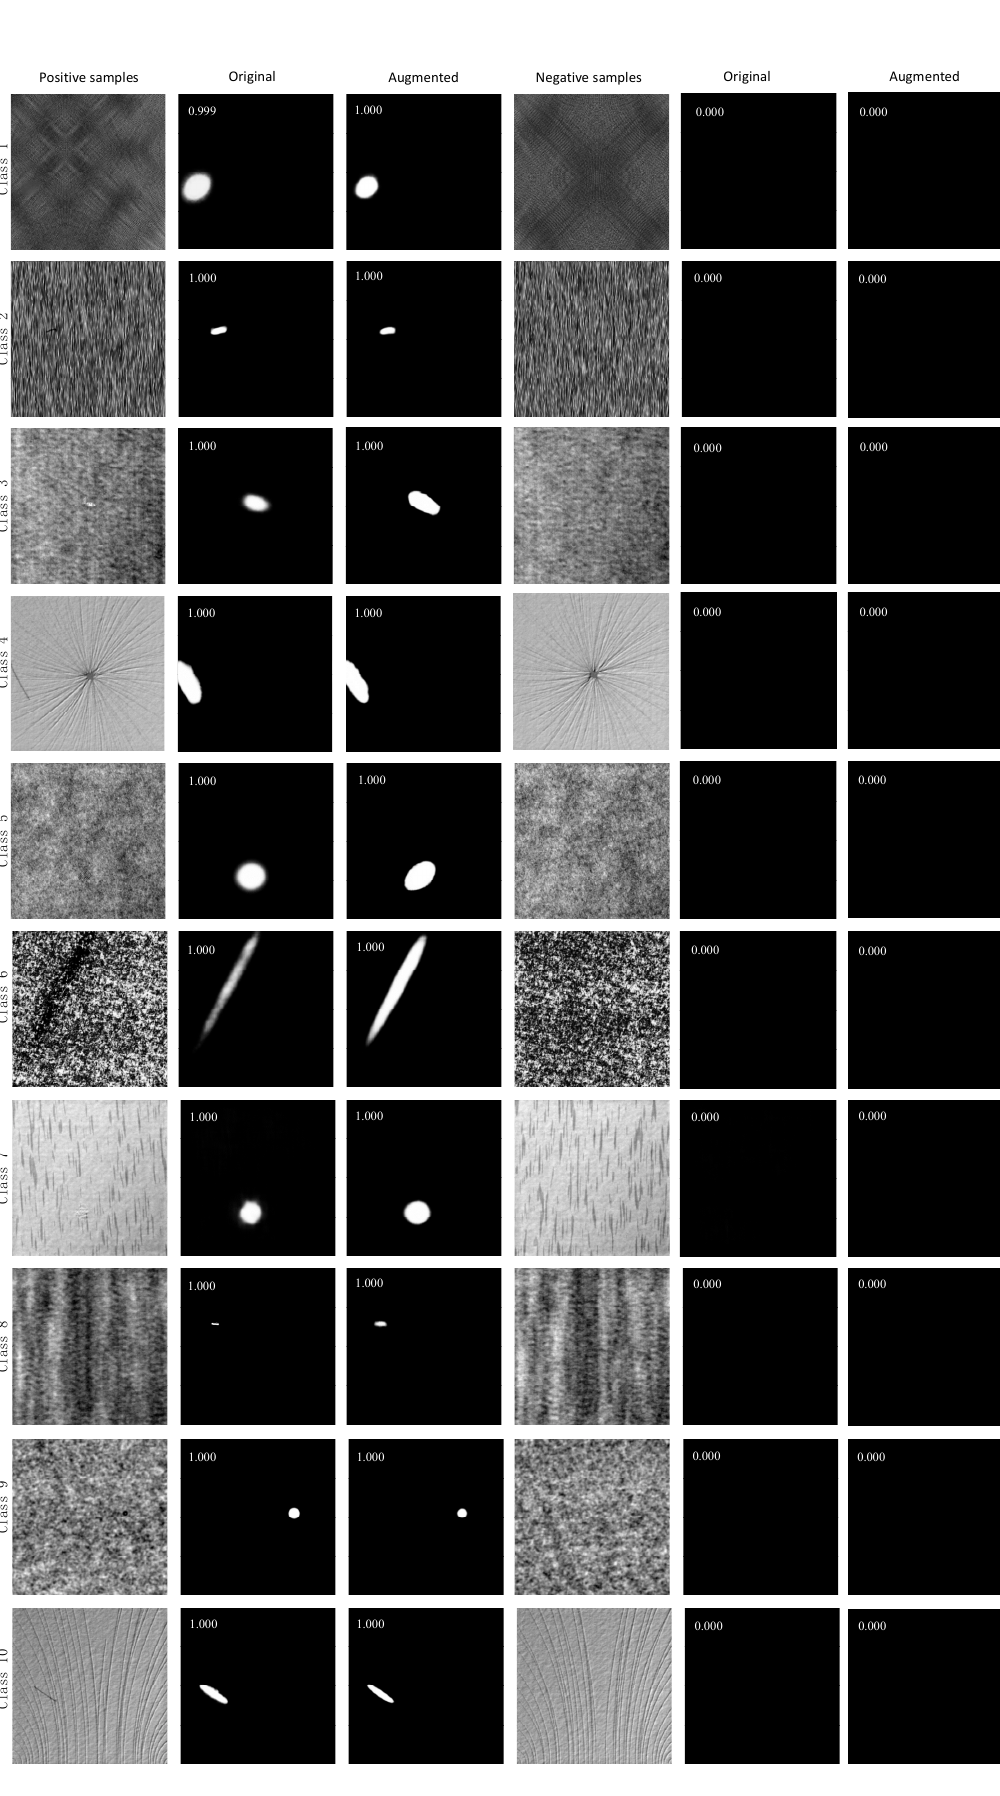
Figure 5 . Examples of segmentation and classification . Figure 5. Examples of segmentation and